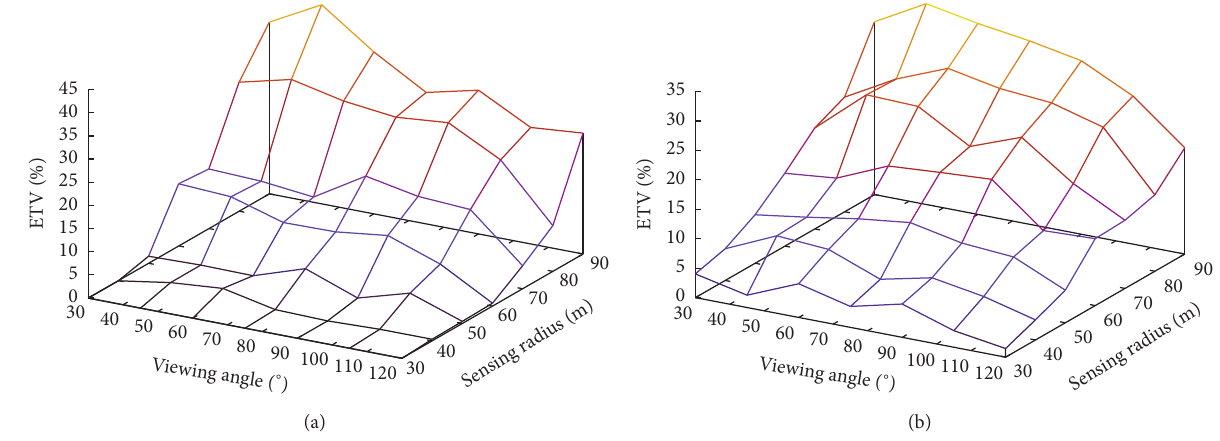
Figure 8: ETV for a specific scenario: (a) 5 targets with 𝑅 (𝑡) = 20 ; (b) 5 targets with 𝑅 (𝑡) = 50 .